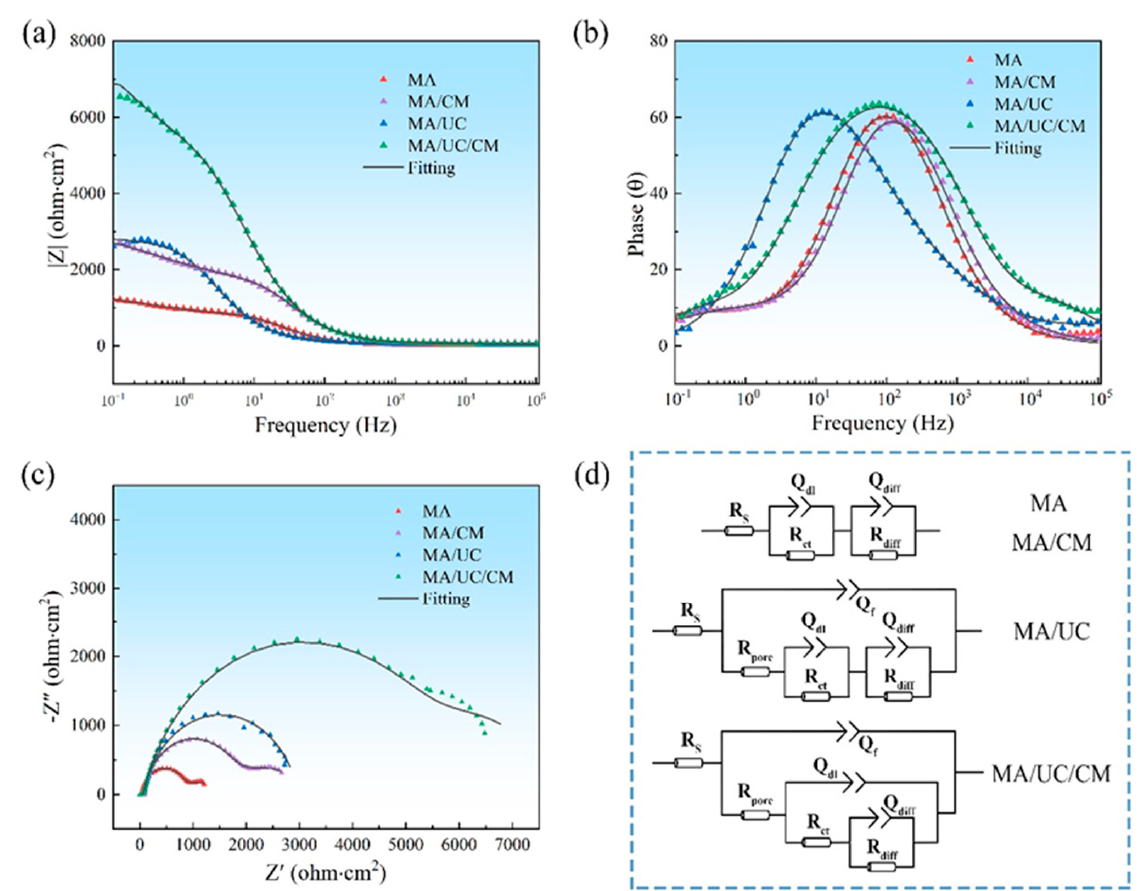
Figure 9. ( a ) Bode plots of the sample after immersion for 1 h: impedance versus frequency; ( b ) Bode plots of the sample after immersion for 1 h: phase angle versus frequency; ( c ) Nyquist plots of the sample after immersion for 1 h; ( d ) equivalent electrical circuits models for the investigated samples.